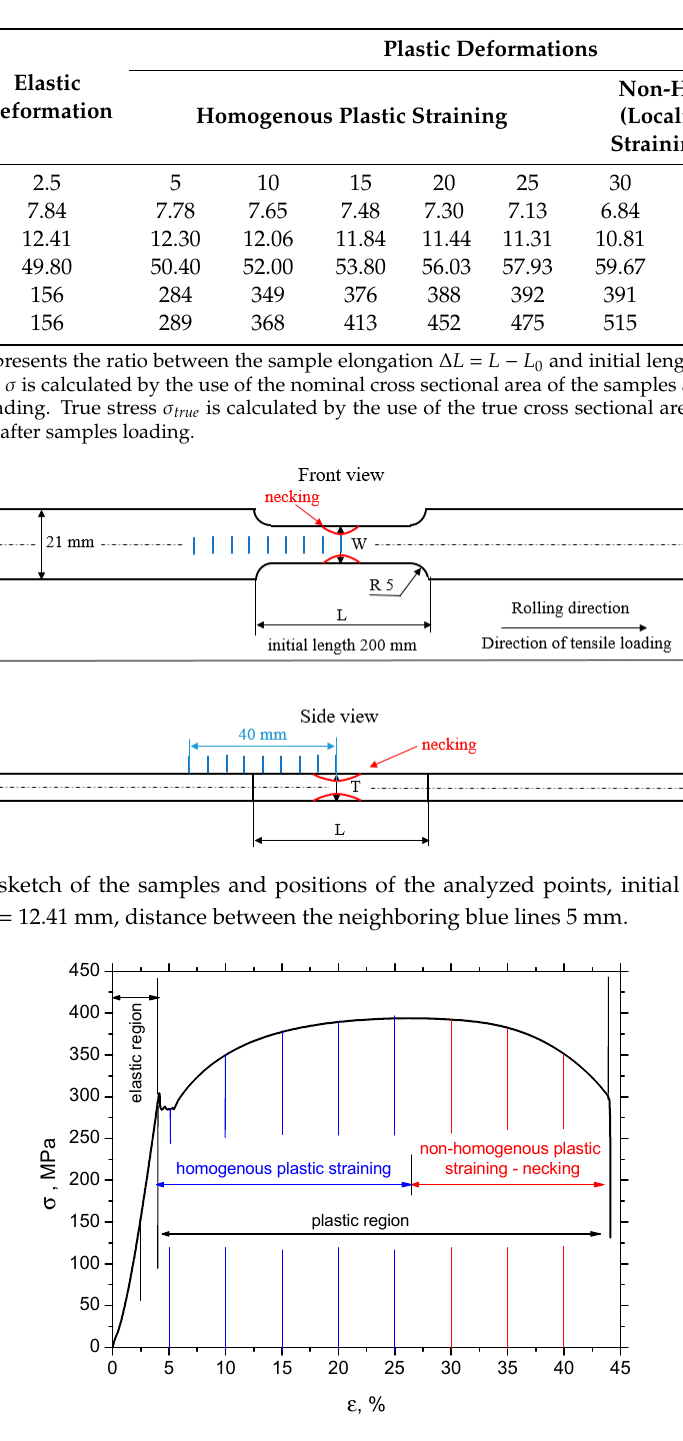
Figure 3. Ferrite matrix (white) with limited volume of pearlite islands (dark), as received. Plastic deformation tends to reduce the cross sectional area (expressed in terms W × T , see Figure 1) and makes the samples longer (expressed in term L , see Figure 1). For this reason, the sample’s dimensions after loading were measured by the use of a caliper measure (precision ± 0.01 mm) in the sample center. The measured values of L , W , and T are shown in Table 2. This table also compares engineering σ and true stress σ true calculated by the use of T and W values. T and W values were found to be nearly constant within the whole L after the homogenous plastic straining. On the other hand, T and W values refer to the dimensions of the neck (indicated by a red color in Figure 1) when the non-homogenous plastic straining takes place. The distance between the neighboring positions (indicated by blue color in Figure 1) was kept constant at 5 mm and drawn after the sample unloading. Due to elongation of the region defined by L during tensile test the number of positions within this region increased from 5 (for the lower strains) to 6 as soon as the strains exceeded 20%. It is also worth to mention that MBN technique indicated altered state of the sample in the region in which the radius R5 occurs (see Figure 1) and beyond the region defined by L distance (outside the thinned region) as well. The true interpretation of MBN signals is associated with the investigation of the interrelated relationships among the MBN, residual stresses, and microstructure. For this reason, the non-